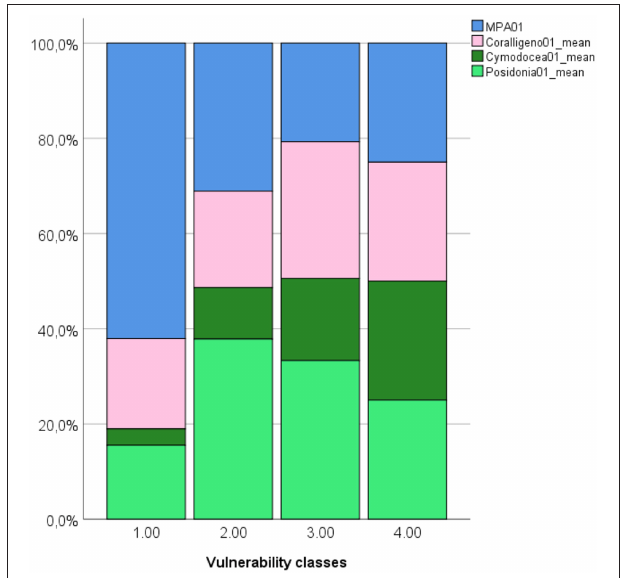
FIGURE 11 | Vulnerability classes description. Only the 4 classes with vulnerability higher than zero are